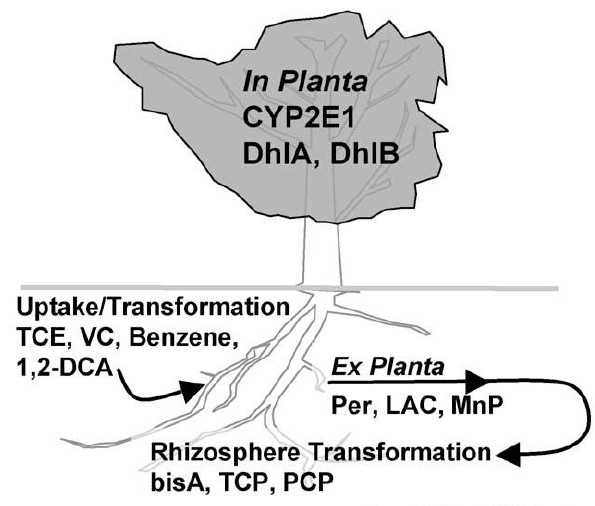
Fig. 3. The phytoremediation was conducted by introducing a hld and had genes into plants. The transgenic plant was able to absorb and detoxify some toxic halogenated compounds